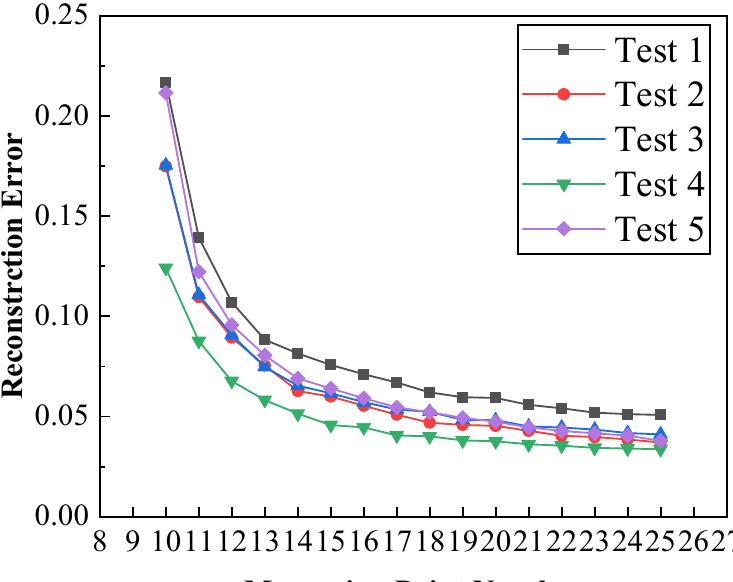
Figure 8. Comparison of reconstruction results with different sensor numbers ( 10 – 25).